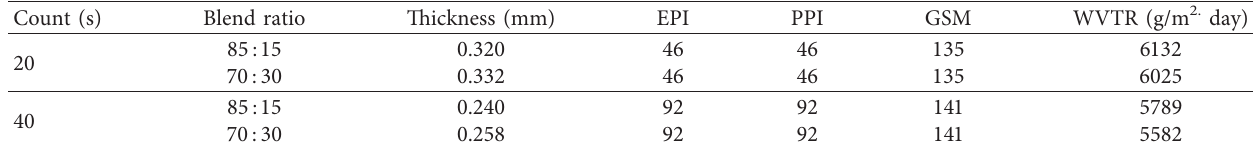
Table 9: The moisture vapor transmission rate (MVTR) of woven